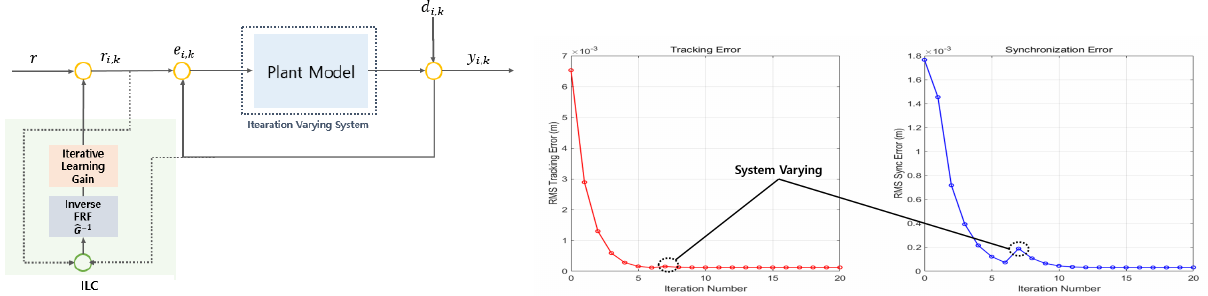
Figure 5. Iteration-varying system convergence.